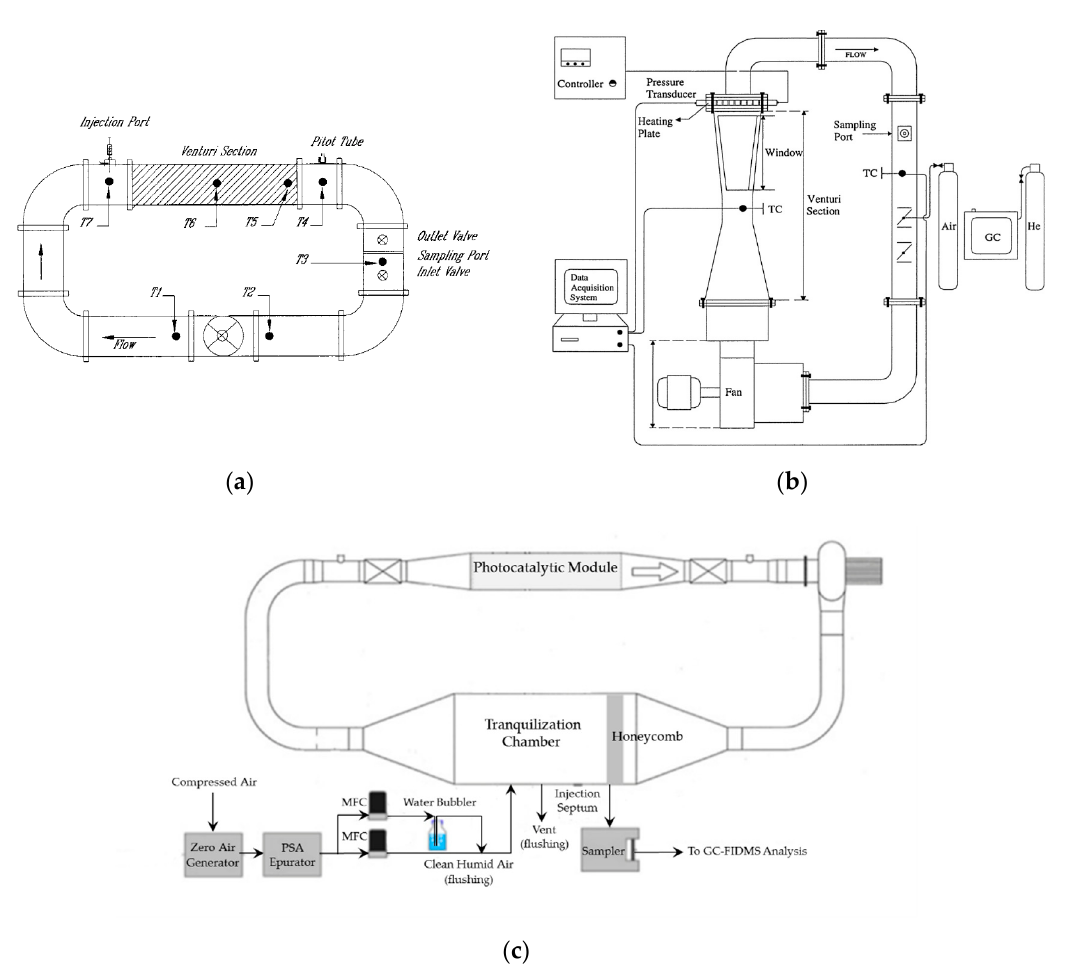
Figure 5. Schematic representation of three experimental closed-loop reactors: ( a ) Photo-CREC-Air Reactor (PCAR-1999 model) [38], ( b ) PCAR-2002 model [2], both designed by Ibrahim et al., and ( c ) closed-loop 2017 model designed by Héquet et al. Diagrams are reproduced with permission [84], MDPI; published by Molecules, 2017.